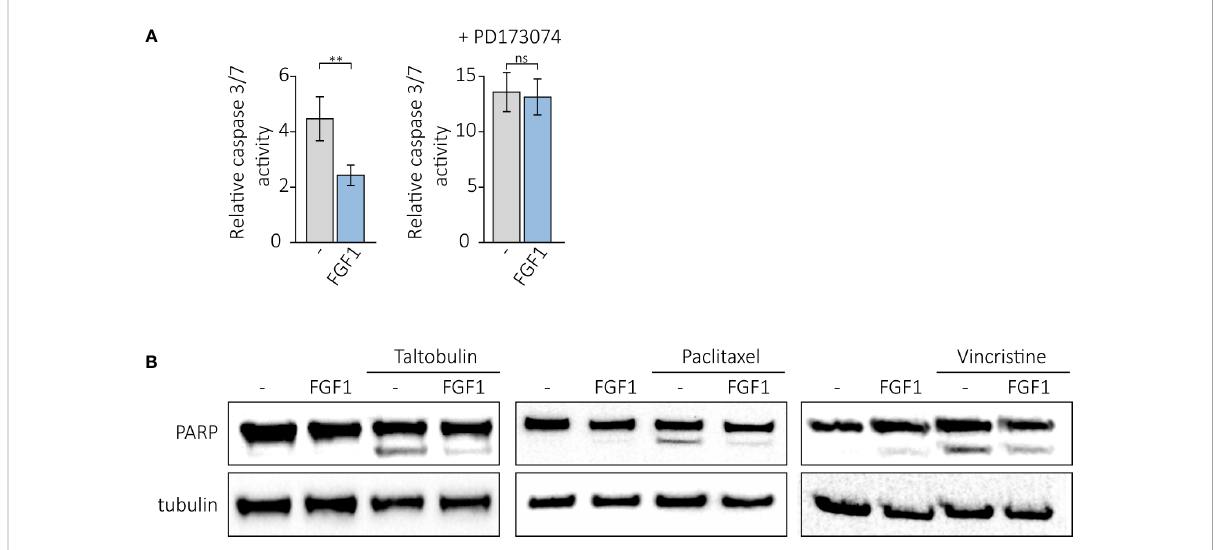
FIGURE 4 Anti-apoptotic effect of FGF1 stimulation in U2OSR1 cells treated with drugs targeting tubulin polymerization. (A) Relative caspase 3/7 activity induced by 5 nM TLT in U2OSR1 cells was measured using ApoLive-Glo Multiplex Assay 24 h after drug administration in the presence or absence of 10 ng/mL FGF1 and 100 nM PD173074. Results represent the mean ± SD of at least three independent experiments and are normalized to untreated cells; statistical signi fi cance: **p<0.01, no signi fi cant difference is marked as ‘ ns ’ . (B) Protective effect of FGF1 against drug-induced apoptosis in U2OSR1 cells assessed by PARP cleavage. Western blotting was performed with anti-PARP antibodies 24 h after administration of 5 nM TLT, 20 nM PTX or 10 nM VCR in the presence or absence of 10 ng/mL FGF1.